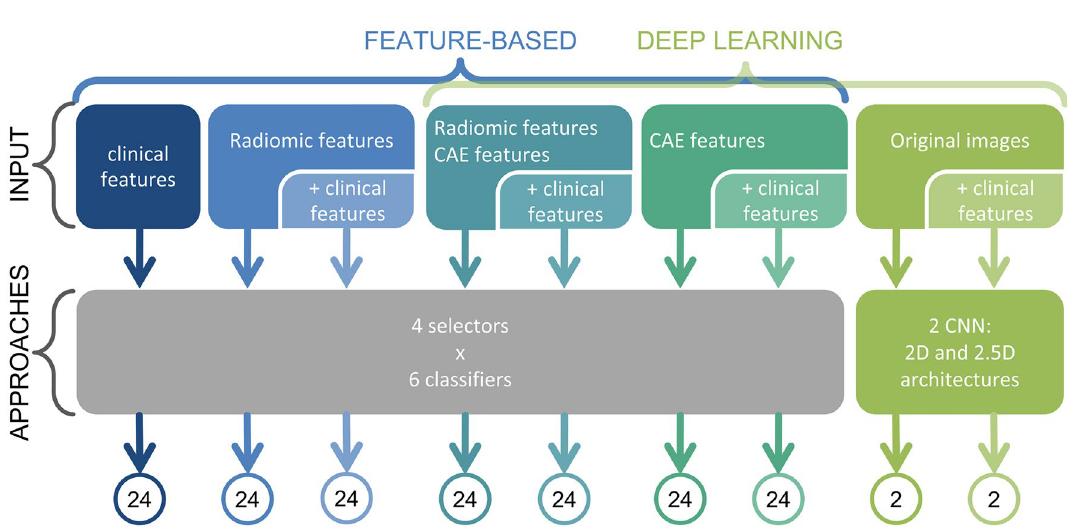
Figure 2. Flow chart of the analysis for the two different classification approaches. In the figure, the number of tested models for each approach is also visible. A total of 168 different pipelines were tested for the feature-based approach (including clinical, radiomic and deep features only and their combination), while 4 architectures were tested for the CNN-based